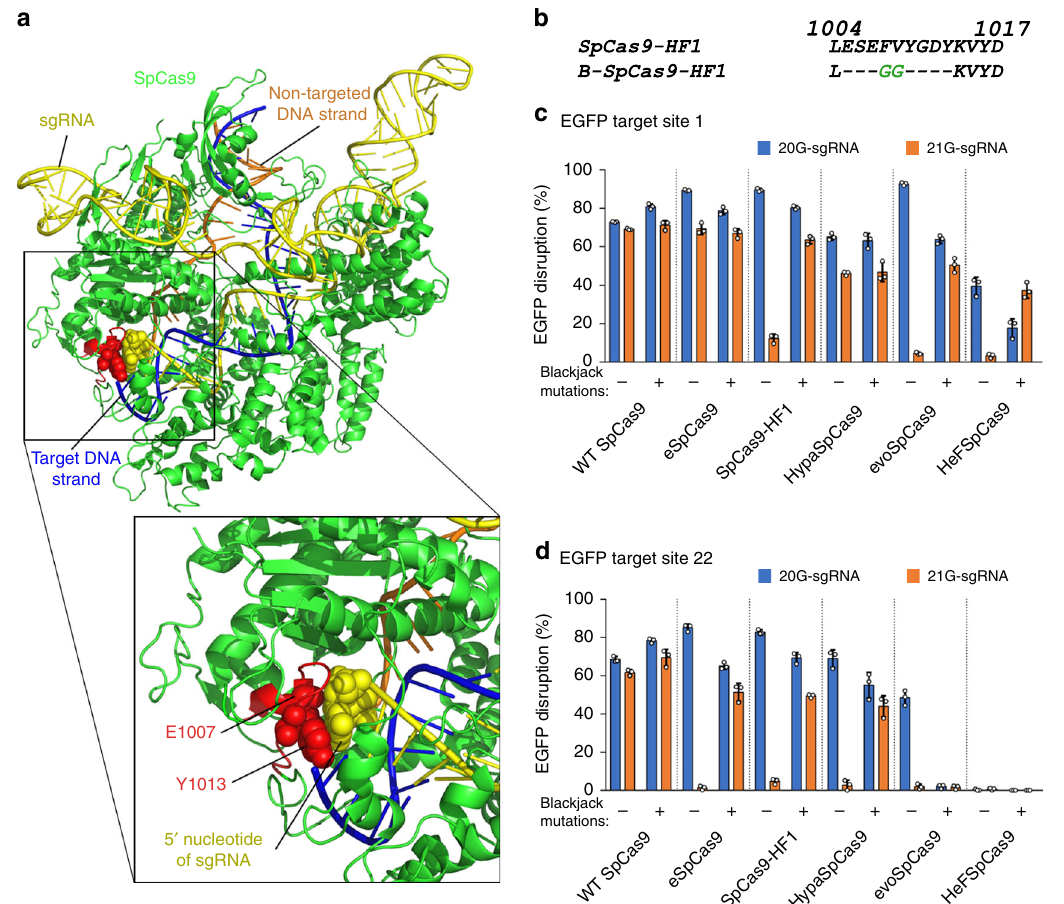
Fig. 1 Structure-guided mutagenesis increases on-target activity of SpCas9-HF1 with 21G-sgRNAs. a X-ray crystallography derived structure of SpCas9- sgRNA-DNA complex in the conformation closest to the cleavage-competent state (PDB ID: 5f9r) 43 . b Sequences of SpCas9-HF1 and the selected Blackjack-SpCas9-HF1 at the region affected, between residues L1004 and D1017; deletions ( − ) and insertions (green) are indicated. See also Supplementary Fig. 1. c , d Blackjack mutations increase on-target activities of increased fi delity variants with 21G-sgRNAs on different targets. Means are shown, error bars represent the standard deviation (s.d.) for n = 3 biologically independent samples (overlaid as white